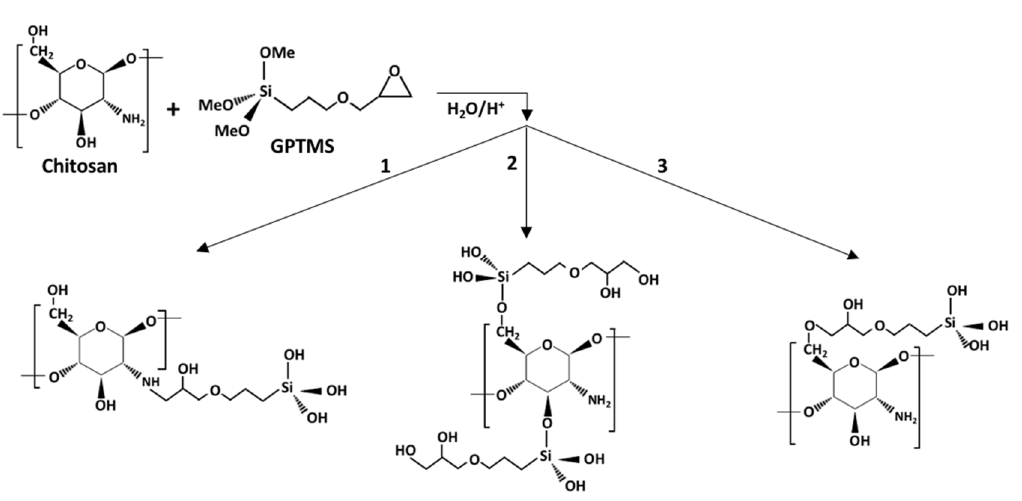
Figure 1. Alternatives routes of functionalization of deacetylated chitosan by GPTMS in acidic medium. ( 1 ) Trough nucleophilic attack of epoxide ring by amine group of chitosan; ( 2 ) by condensation of silanol and OH groups of chitosan; ( 3 ) by nucleophilic attack of epoxide by OH group of chitosan [40].